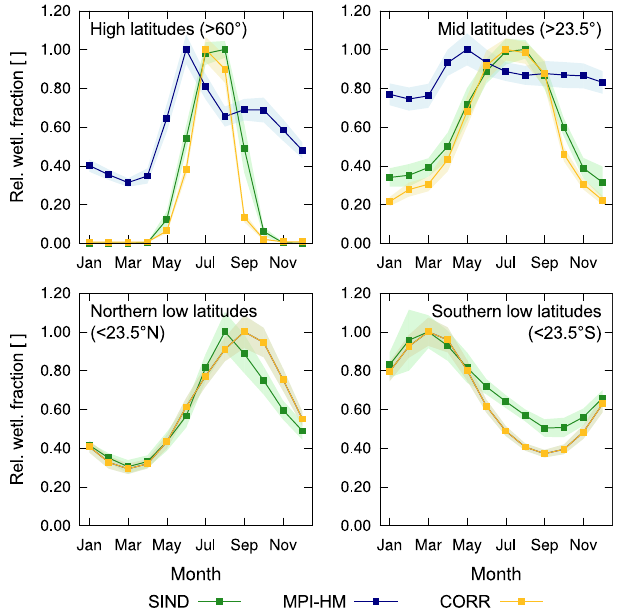
Fig. 8. Seasonality of wetland extent relative to its maximum for different latitude bands. The green color indicates the SIND obser- vations, the blue the MPI-HM results and the yellow line represents the MPI-HM results corrected with the snow mask. For low latitudes the yellow curve lies on top of the blue because the snow mask has no significant impact on the wetland fraction in these regions. The shaded areas indicate the standard